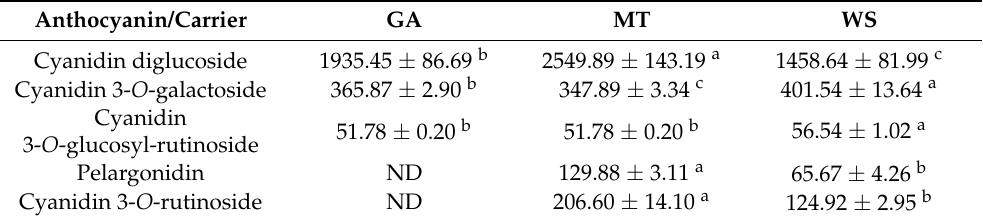
Figure 3. An illustration of LC-MS chromatographic separation of gum Arabic, maltodextrin, and waxy-starch-encapsulated raspberry juice powders. Table 4. Individual anthocyanin compounds (µg/g) of the freeze-dried raspberry juice powders developed using different carriers.